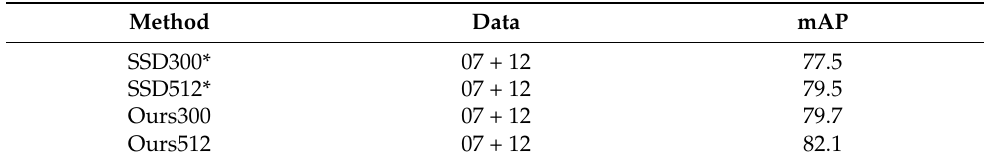
Table 1. Results on PASCAL VOC2007 test set (07 + 12 denotes data are trained with VOC07 and VOC12 trainval